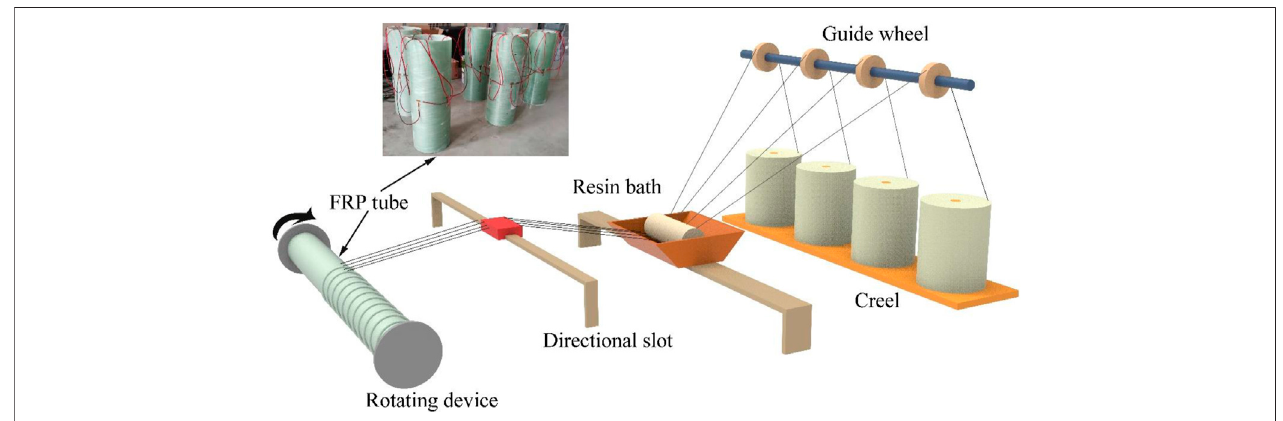
FIGURE 2 | Manufacturing process of FRP tubes.